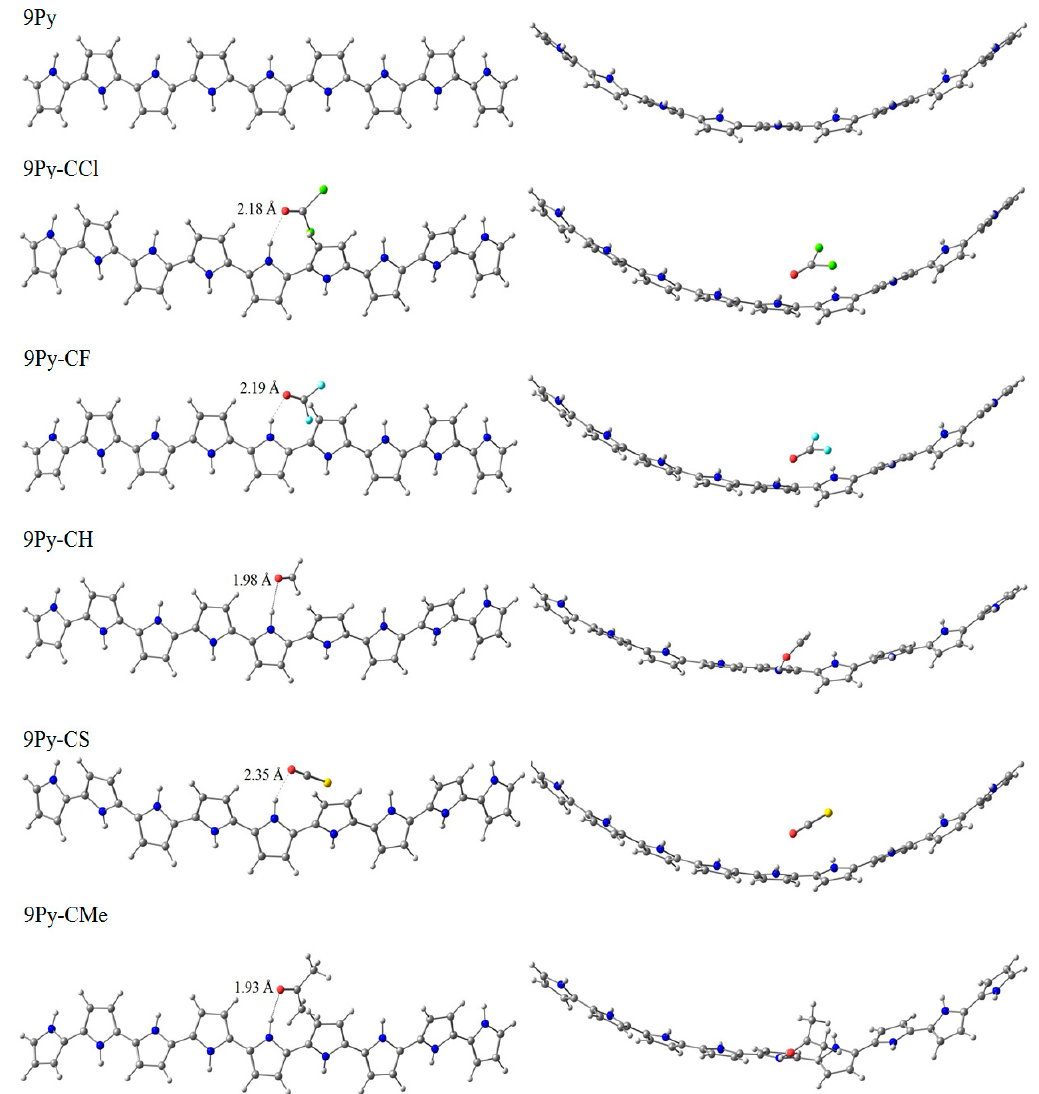
Figure 2. Optimized structures for 9Py-HC complexes (HC = CCl, CF, CH, CS, and CMe) at the B3LYP-D3(BJ)/6-31+G(d) level in the gas phase.